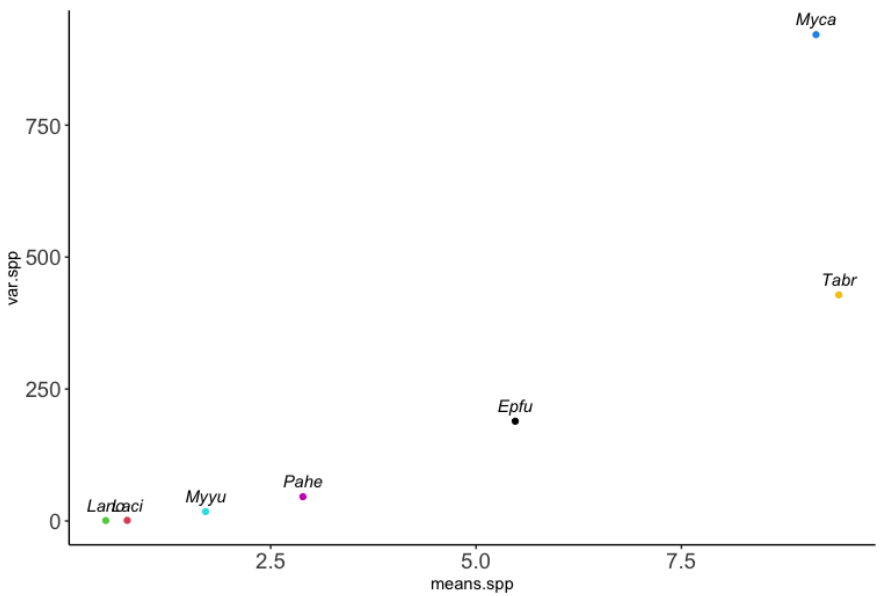
Figure 2. The sample variance of observed counts against the sample mean for seven bat species (spp.) using the acoustic count data. The mean-variance relationship is clearly non-linear (in fact, close to quadratic), indicating evidence of overdispersion. Seven bat species were recorded in oak woodlands of California labelled by the following abbreviation: Tadarida brasiliensis (Tabr), Eptesicus fuscus (Epfu), Lasionycteris noctivagans (Lano), Lasiurus cinereus (Laci), Parastrellus hesperus (Pahe), Myotis yumanensis (Myyu), and Myotis californicus